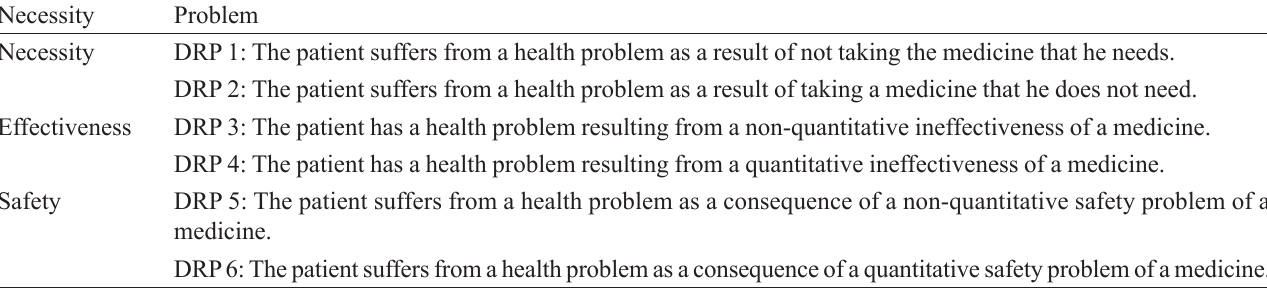
TABLE I – Classification of ‘Drug Related Problems’ (DRP) Necessity Problem Necessity